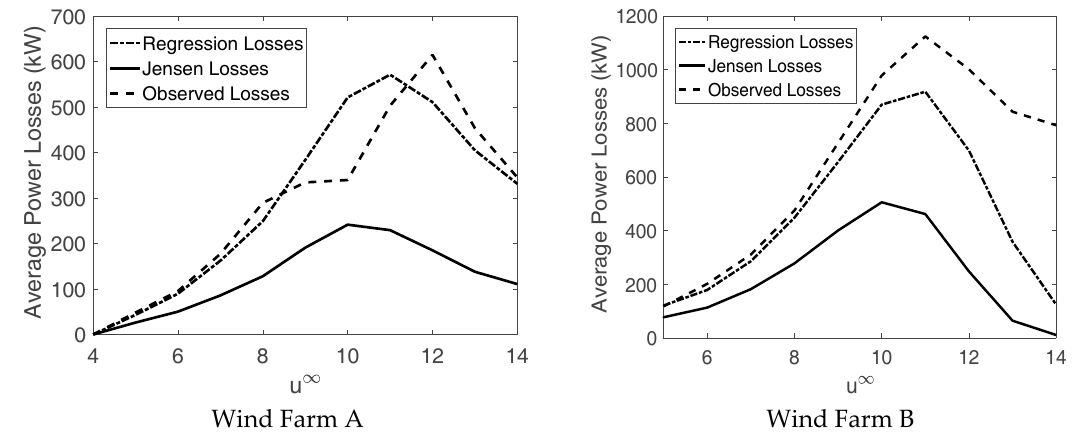
Figure 7. Wake losses as a function of wind speed, wind farm A ( left ) and wind farm B ( right ).